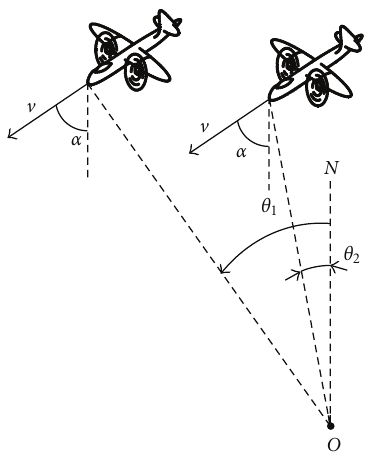
Figure 2: Polar coordinates (angles of arrival) of the planes (objects) being detected.